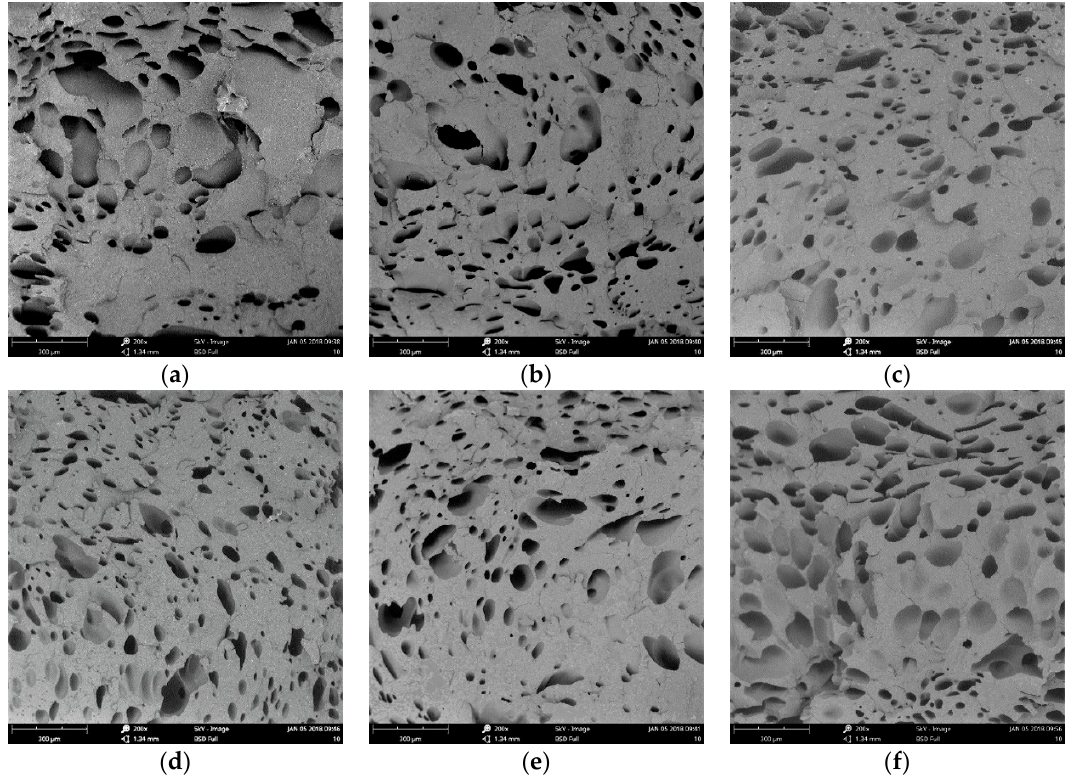
Figure 10. The results of the cell structure of the core layer of the vertical sections with different content of nano-CaCO 3 : ( a ) 0 wt % ; ( b ) 2 wt % ; ( c ) 4 wt % ; ( d ) 6 wt % ; ( e ) 8 wt % ; ( f ) 10 wt % .